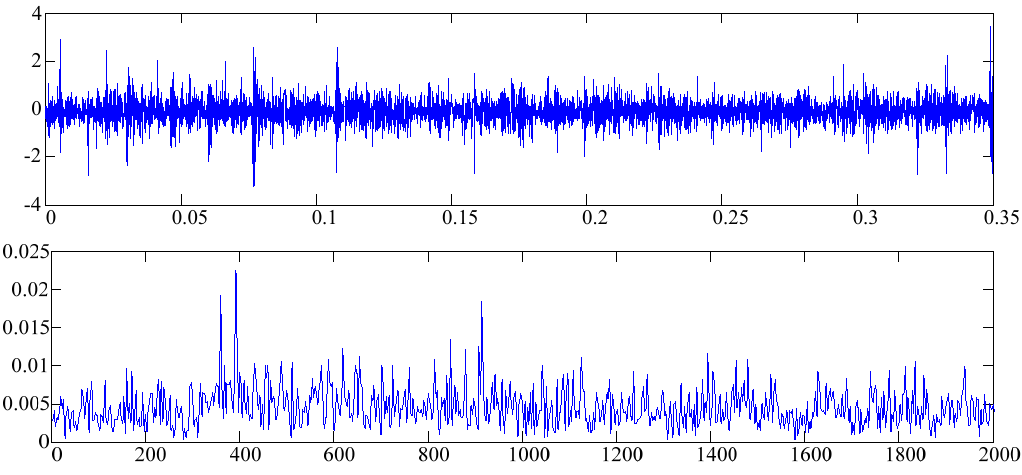
Figure 11. Time and frequency domains of the sixth channel signal.